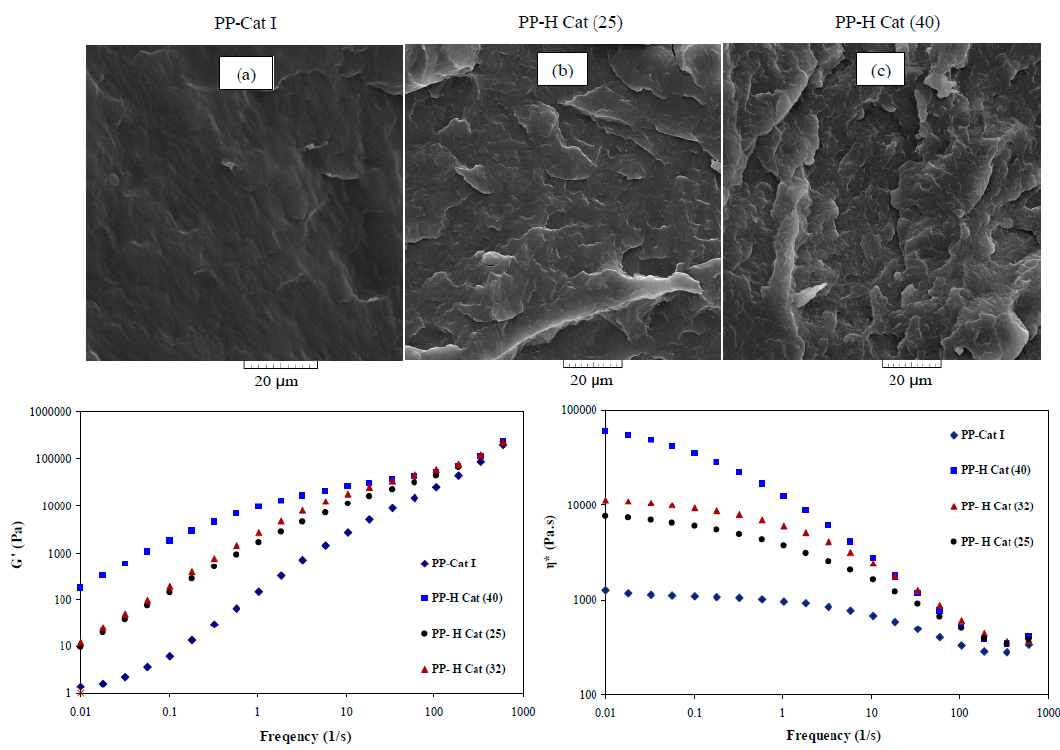
Figure 11. Relationship between the morphology and linear rheology of PP reactor blends synthesized at different cat (II)/cat (I) molar ratios.